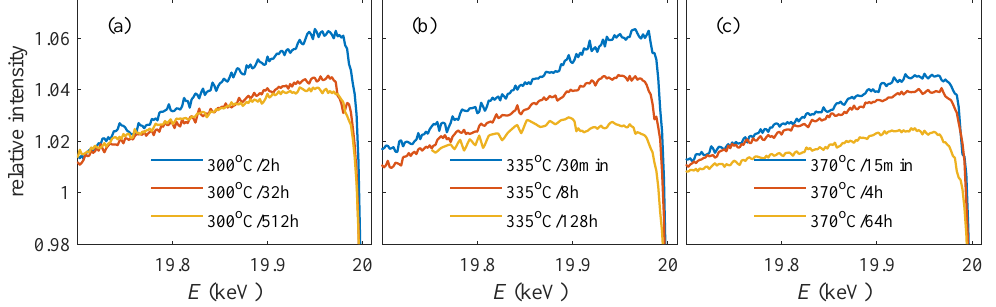
Figure 4. The AXRD spectra of intensities integrated over the detector window of the whole sample series: ( a – c ) the spectra of samples aged at 300 ◦ C, 335 ◦ C, and 370 ◦ C, respectively. The intensities are normalized to their values at 19.6